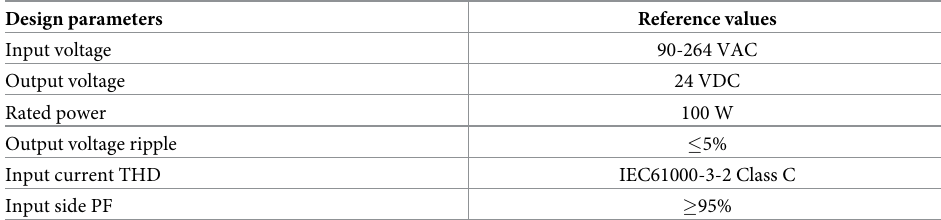
Table 1. Design parameters of Buck PFC circuit.